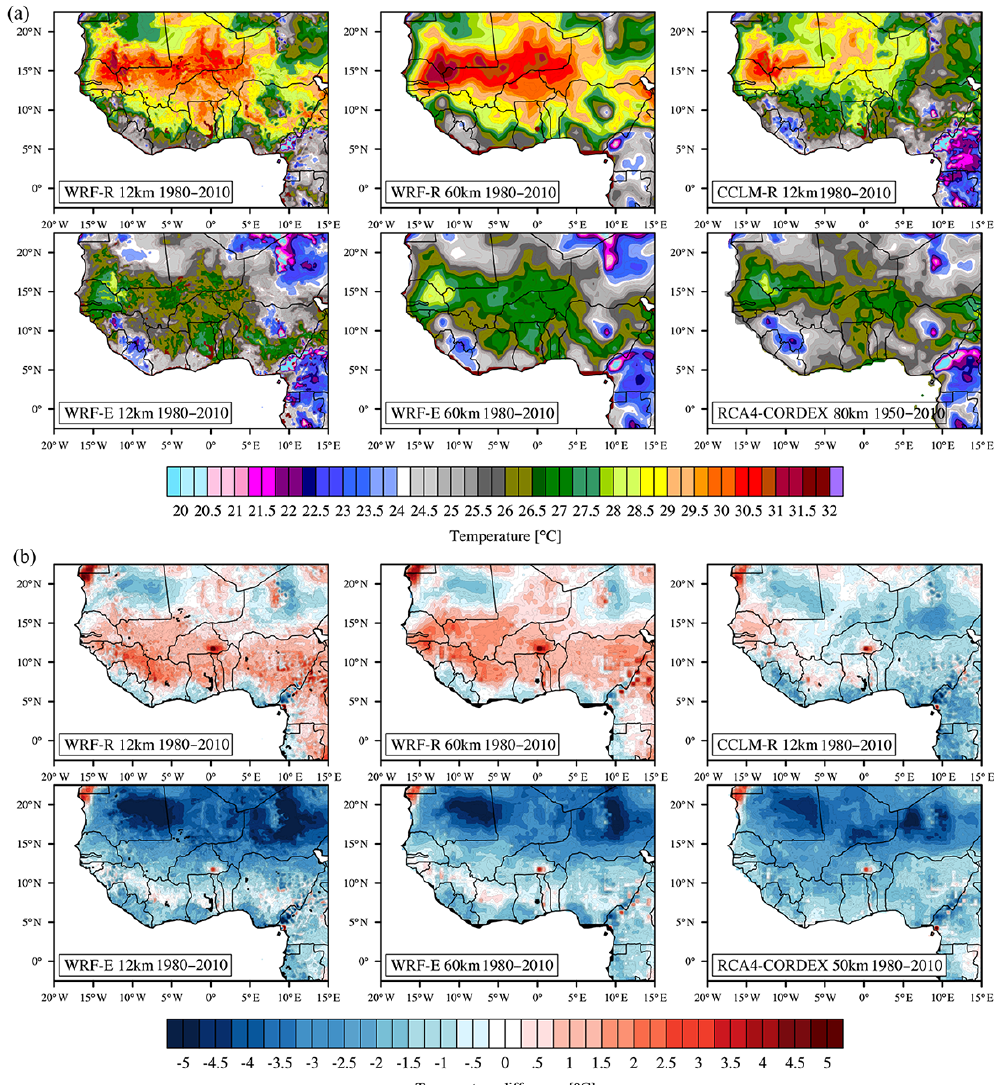
Figure 4. Near-surface temperature averaged over the historical reference period 1980–2010 (a) and differences to AgMERRA reanalysis data (b) for the WRF control runs WRF-R, the WRF multi-model ensemble WRF-E, a CCLM control run CCLM-R and a two-member ensemble